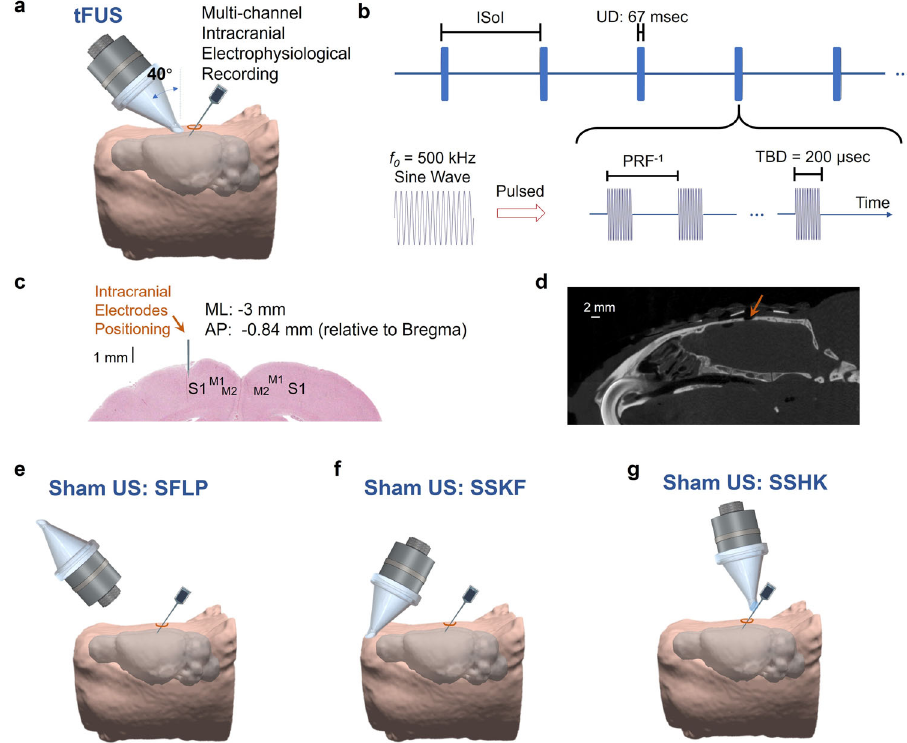
Fig. 1 The experimental setup of ultrasound stimulation and intracranial electrophysiological recording. a Collimator guiding focused ultrasound to hair- removed scalp of an anesthetized rat model with an incidence angle of 40°, and a 32-channel electrode array inserted at an incidence angle of 40° into the left primary somatosensory cortex (S1) prepared through a craniotomy. The rat head and brain model were 3D reconstructed from T 2 -weighted (T2W) MRI images 94 . b The temporal pro fi le of the transcranial focused ultrasound (tFUS). One-hundred cycles of sinusoidal wave formed a single ultrasound pulse, which generated a tone-burst at an ultrasound fundamental frequency ( f 0 ) of 500 kHz for a tone-burst duration (TBD) of 200 μ s. Such ultrasound pulses were repeated at certain PRF for a corresponding number within the ultrasound duration (UD) of 67 ms. The inter-sonication interval (ISoI) was 2.5 s, and some ISoI had 10% jittering, in which the ISoI was randomly selected from a uniform distribution centered at 2.5 s, bounded by ±250 ms. c The spatial coordinates of electrophysiological recordings. The coronal brain slice shows the location of electrode insertion with the insertion depth of 1 mm at the left S1. ML denotes the medial lateral distance from midline; AP denotes the anterior posterior distance from Bregma. d A sagittal view of the micro-CT image captured the surgical burr hole (approximate diameter: 2 mm) on the top of cranium. The micro-CT scan was repeated for six times independently with similar results. e The experimental setup of the sham ultrasound condition as a negative control (SFLP). The acoustic aperture of the ultrasound transducer was fl ipped by 180°, while the pulsed ultrasound and the intracranial recordings were maintained. f The experimental setup of another sham ultrasound condition as a control for bone-conduction (SSKF). The ultrasound incidence took place at an anterior location of the skull with active ultrasound transmission. g Another sham control on electrode shank, i.e., SSHK, is delivered to investigate potential effects of electrode vibrations on neuronal activation. As shown, in the SSHK sham condition, ultrasound is delivered to the shank of the electrode away from the recording sites as further depicted in Fig.